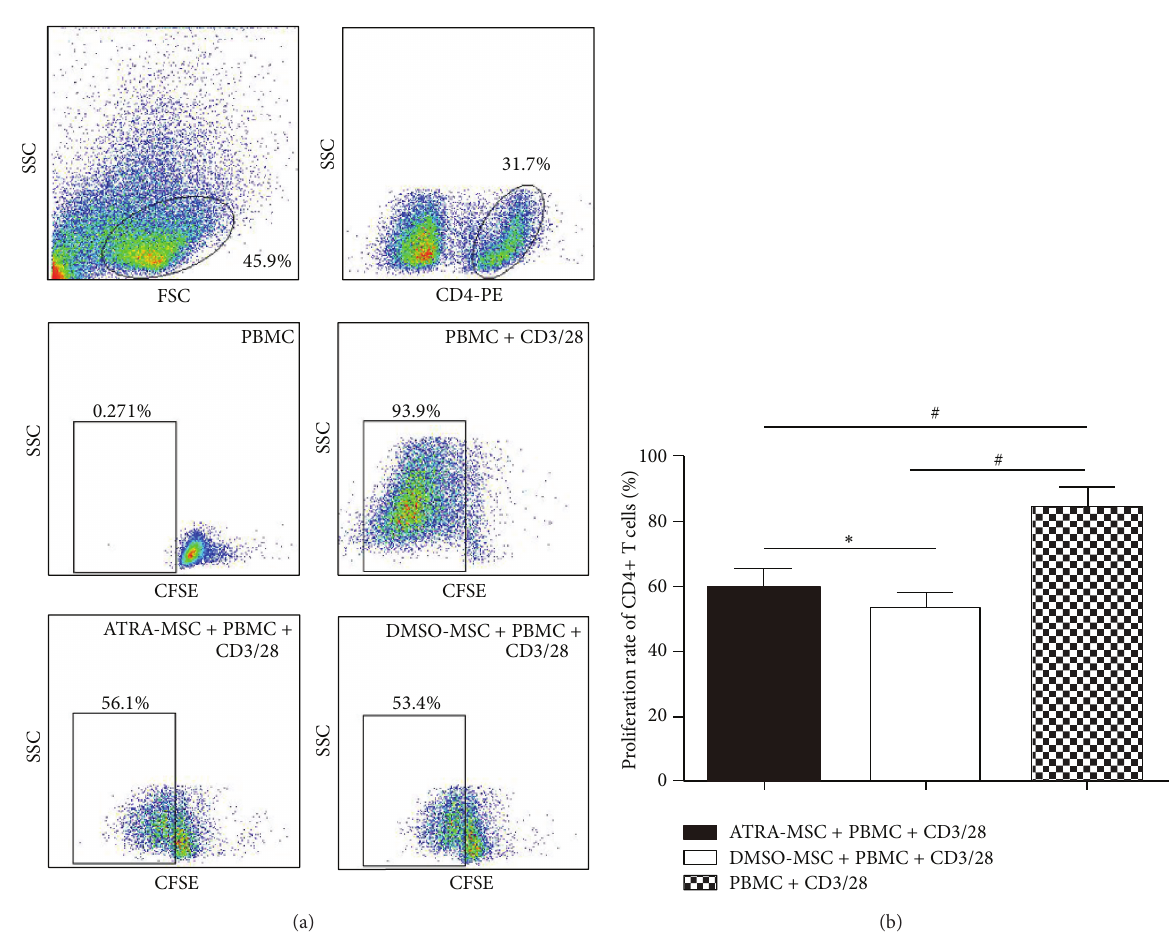
Figure 2: The proliferation rate of CD4+ T lymphocytes incubated with CFSE. (a) Nonactivated T cells were used as controls. (b) When stimulated by CD3/28, the proliferation rate of CD4+ T cells was extremely high ( 83.7±6.7 %). When cocultured with MSCs, the proliferation ofCD3/28-stimulatedCD4+Tcellswasinhibited,butaslightlyhigherproliferationratewasobservedinATRA-pretreatedMSCs( 58.8±6.2 %) than that in DMSO-pretreated MSCs ( 52.4 ± 5.5 %). One-way ANOVA was used. ∗ 𝑃 < 0.05 and # 𝑃 < 0.001